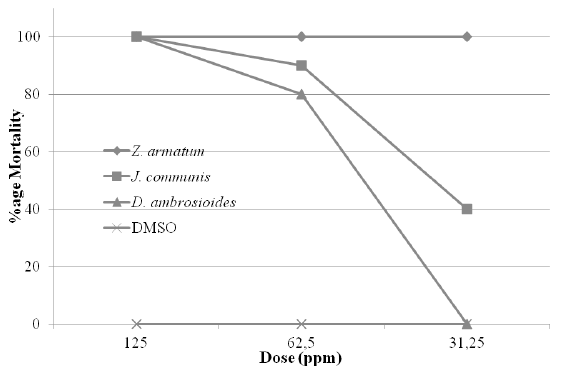
Figure 2: Percent mortality at various dosages of the essential oils of D. ambrosioides, Z. armatum and J. communis against 1-d old Aedes aegypti . In this bioassay, permethrin was used at a dose of 0.025 ppm as positive control which gave 100% larval